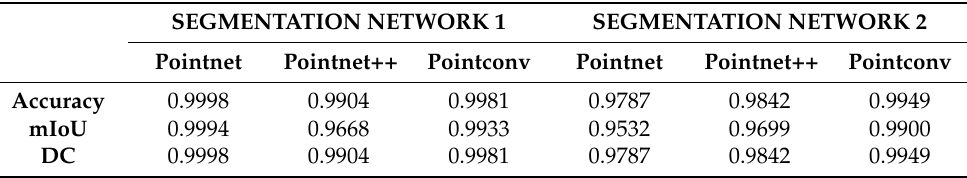
Table 1. Performance evaluation for segmentation network.